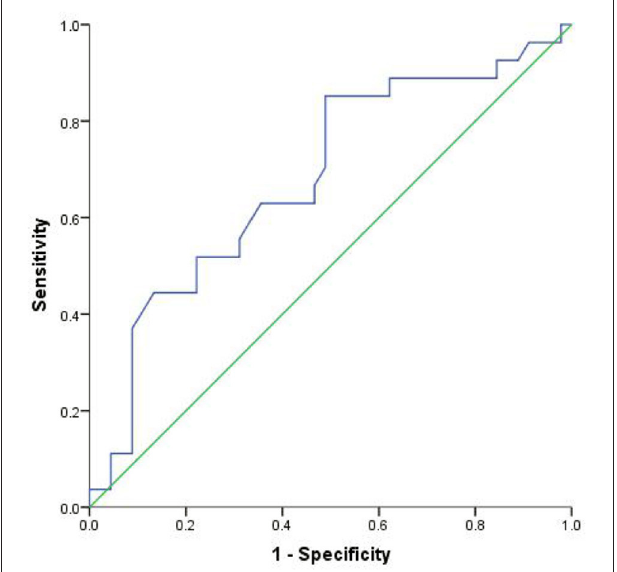
FIGURE 1 | ROC curve of ALB.